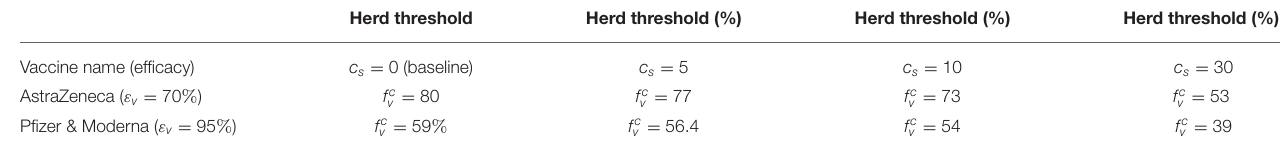
contour plot of R c , as a function of f v and ε v . The results obtained ( Figure 3B ) show that the values of the control reproduction number for the U.S., during the simulation period (October